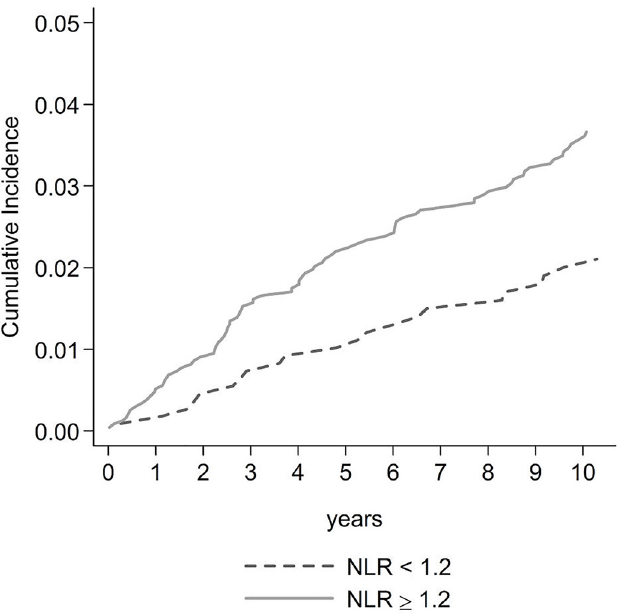
Fig 1. Cumulative incidence CVD curves in HIV-infected subjects with NLR < 1.2 and NLR (cid:1) 1.2. Abbreviation: NLR, neutrophil to lymphocyte ratio.